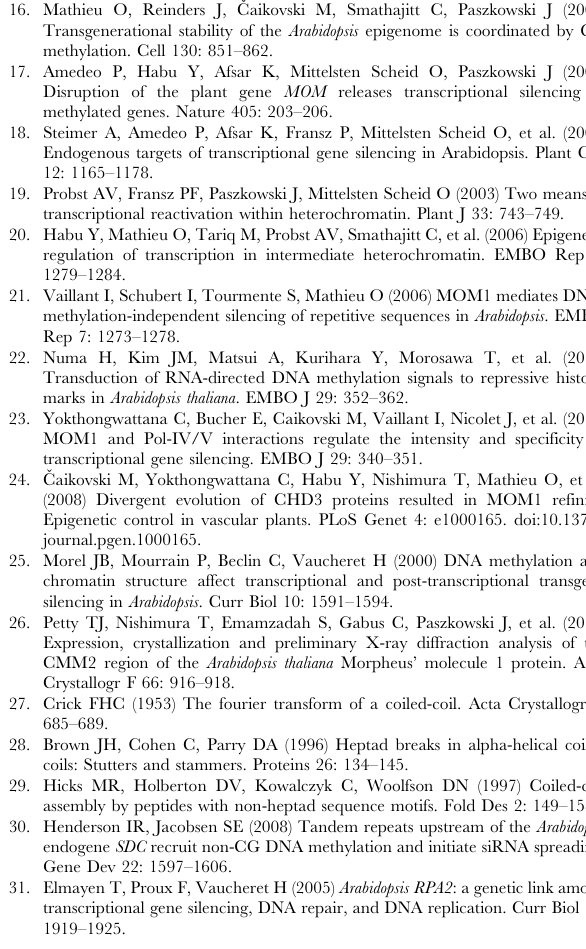
Figure S2 Mutant derivatives of miniMOM1 protein are stably expressed. (A) Relative levels of GUS mRNA determined by quantitative RT-PCR and normalized to 18S rRNA. For each construct 40–50 progeny plants of independent T1 transgenics (A and B) transformed with mutant derivatives of miniMOM1 were used for RNA isolation. Error bars represent S.E. calculated from 2 technical replicates. The mean of technical replicates of T1 plant B transformed with ‘‘empty vector’’ was set to 1. (B) Top , western blot revealing the levels of HA-tagged miniMOM1 and its mutant derivatives in 1-week-old T2 plants whose siblings were used in (A). Bottom , Coomassie Brilliant Blue-stained parallel gel. Figure S3 Relative silencing efficiency (SE) of miniMOM1- mediated TGS at various chromosomal targets. (A) Silencing efficiency at MOM1 targets regulated in cooperation with RdDM and (B) silencing efficiency at MOM1 targets regulated mostly by MOM1 alone. Columns marked (1) ‘‘SE in WT ‘‘ (set to 100%), and columns marked (2) ‘‘SE in mom1 complemented by miniMOM1 ’’ were calculated as ratios of the relative expression in ‘‘empty vector in WT’’ and in ‘‘miniMOM1 in mom1 ’’ (Figure 5). The values of ‘‘SE in mom1 complemented by miniMOM1’’ are shown above columns. Figure S4 TGS activity of the CMM2 domain for chromosomal targets. Relative levels of mRNAs in T2 plants of various MOM1